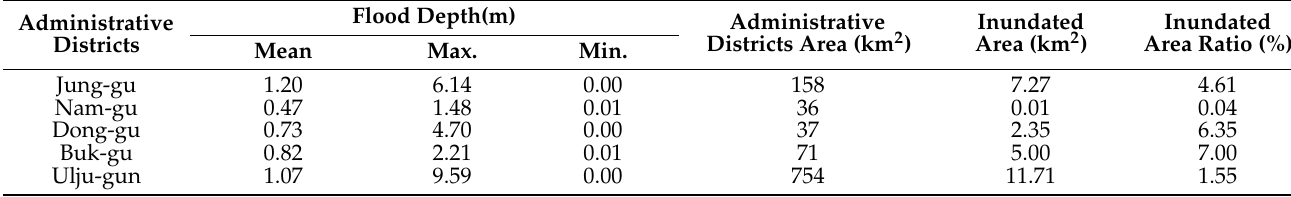
Table 7. Analysis results of hazard (100-year flood map).